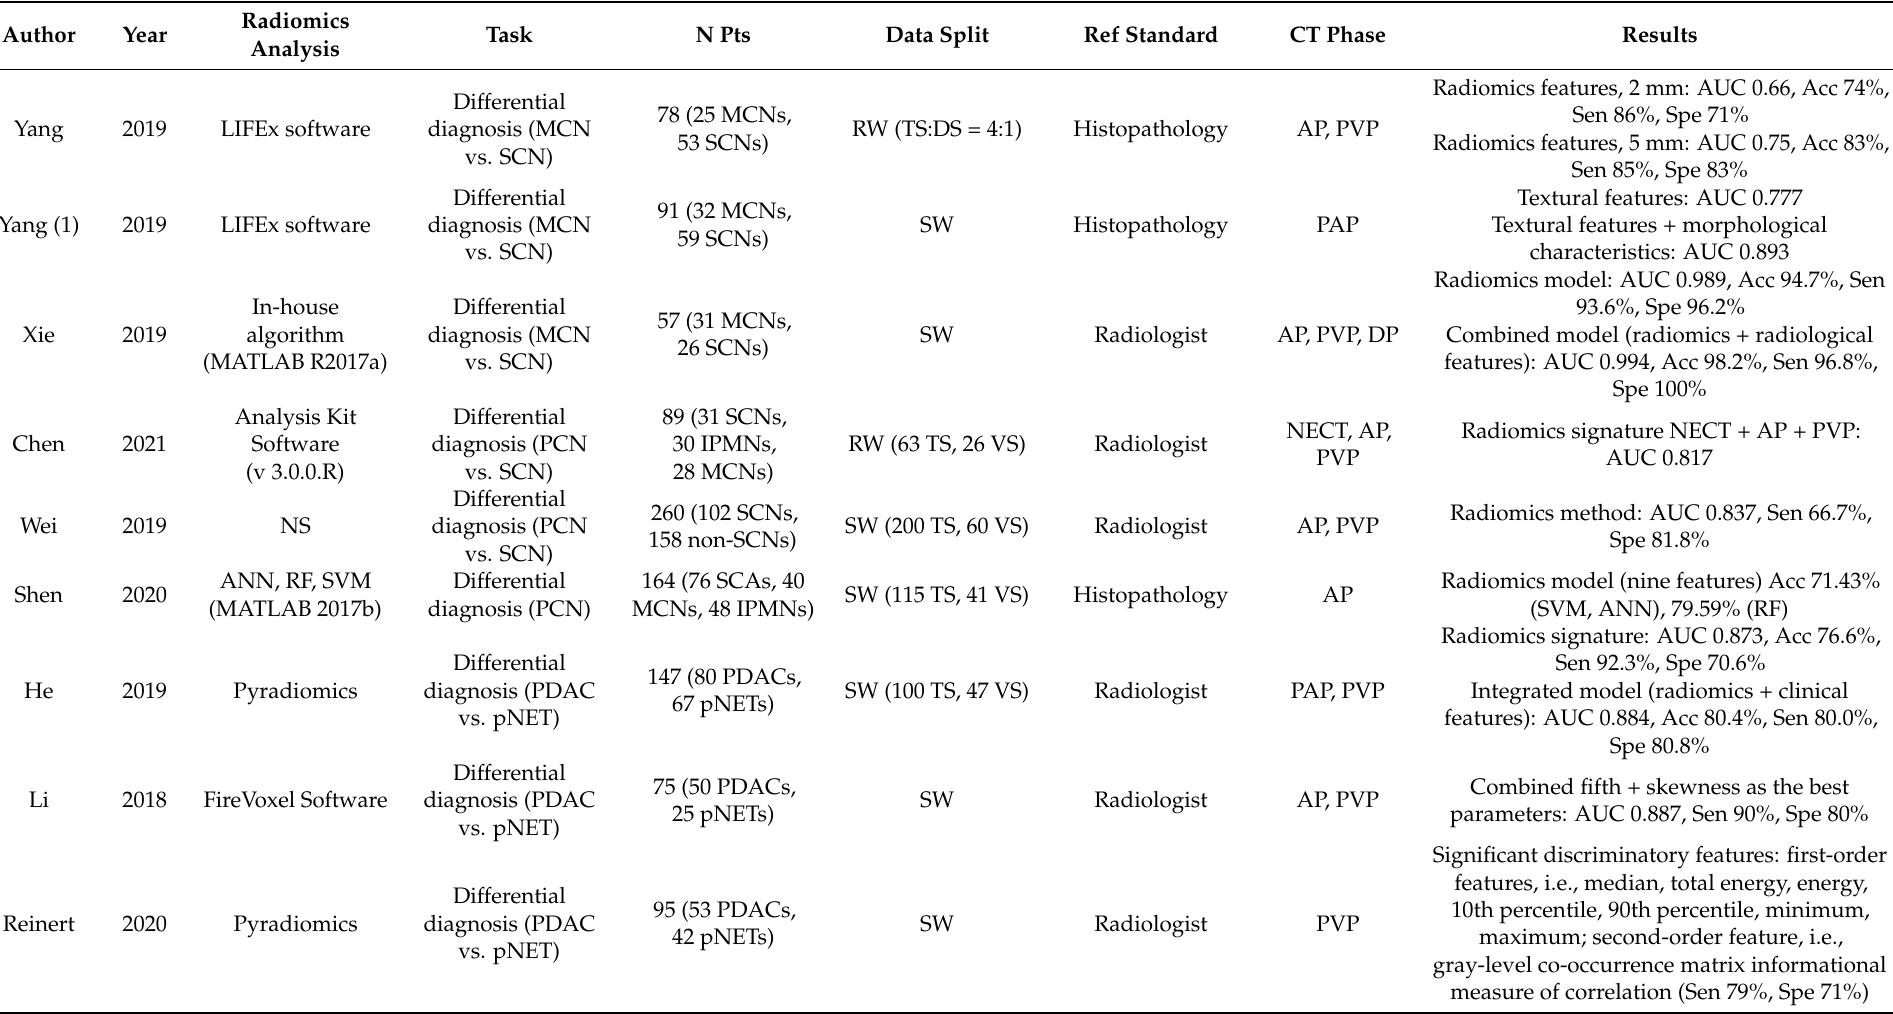
Table 1. Applications of radiomics in pancreatic CT